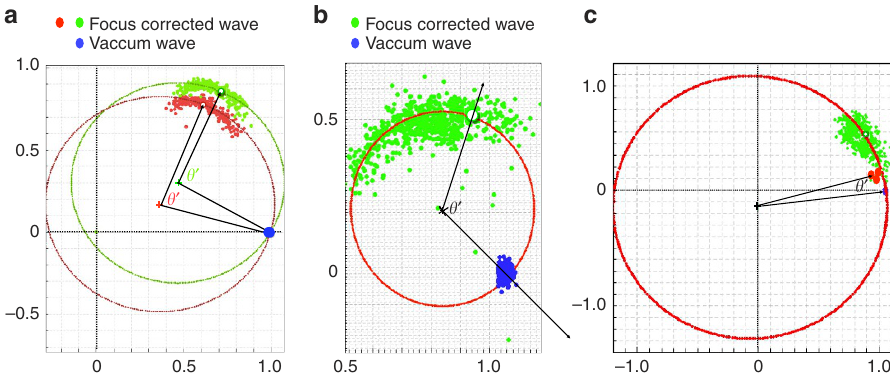
Figure 9 | Plot of the mass circle and the phase of h 0 . ( a ) Ge. ( b ) Au bridge. ( c ) MgO. The green dots and red dots are FCWs , and the blue dots are the vacuum wave. The green and red dots in Ge case are the FCW from right and left columns of the dumbbell pairs. The red dots in the MgO case are the FCW from the